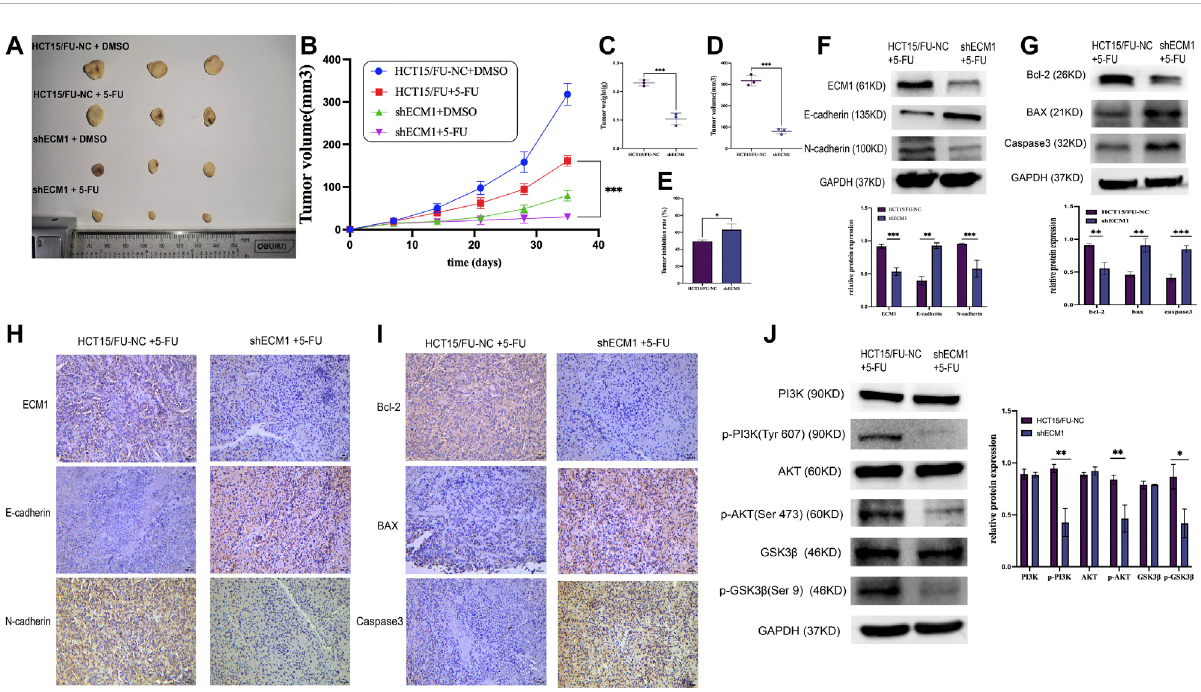
FIGURE 7 Knocking down ECM1 enhances the in vivo chemosensitivity of HCT15/FU cells. (A – E) Knocking down ECM1 enhanced the 5-FU sensitivity of tumor cells, as evidenced by decreased tumor volume and weight on day 28 post-treatment with 5-FU. (F – I) Western immunoblotting and IHC staining were used to detect apoptosis-, EMT- and pathway-related proteins. Data are means ± SD (* p < 0.05, ** p < 0.01, *** p < 0.001). (J) Western immunoblotting was used to detect PI3K/AKT-related protein